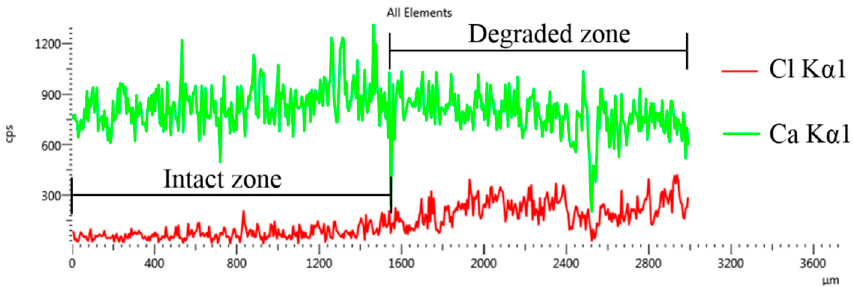
Figure 14. The EDS data for a specified line in Figure 13(c).